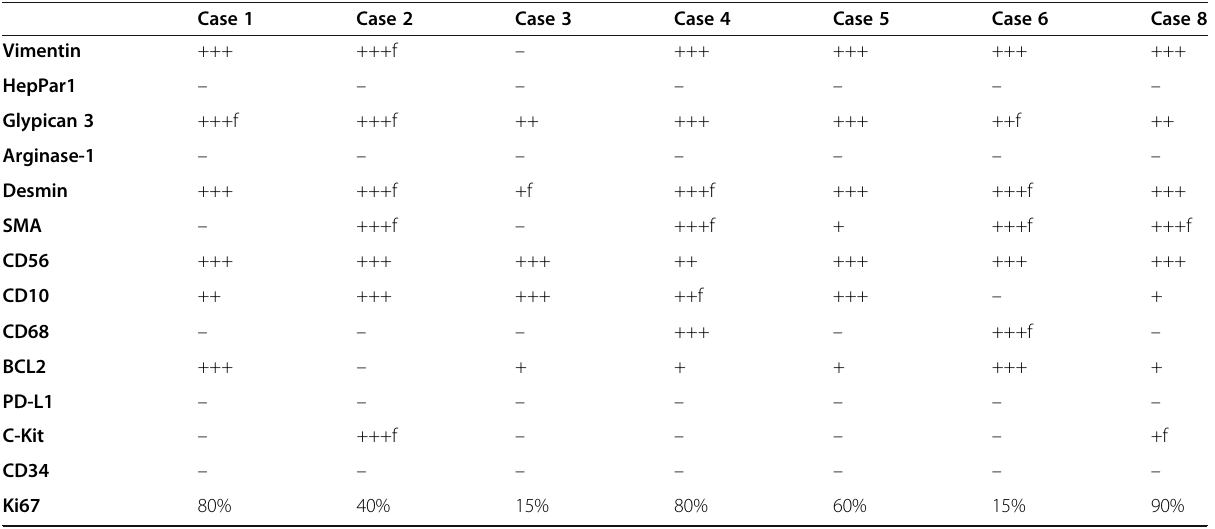
Table 5 Immunohistochemistry findings in UESL cases. +++: strong staining intensity; ++: moderate staining intensity; +: weak staining intensity; f: focal staining